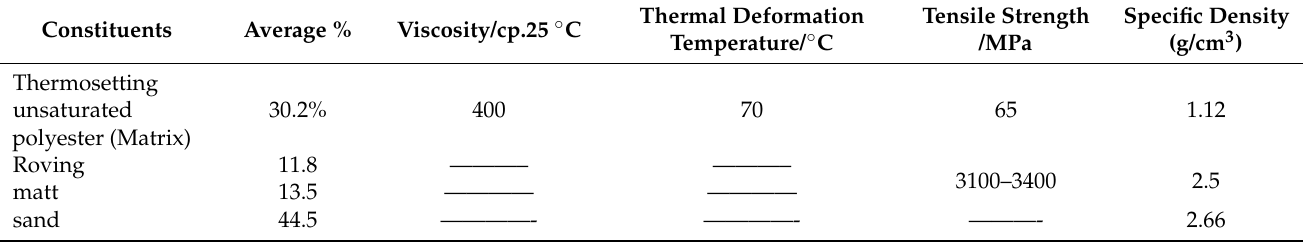
Table 1. Composition of GFR pipes [20,26].